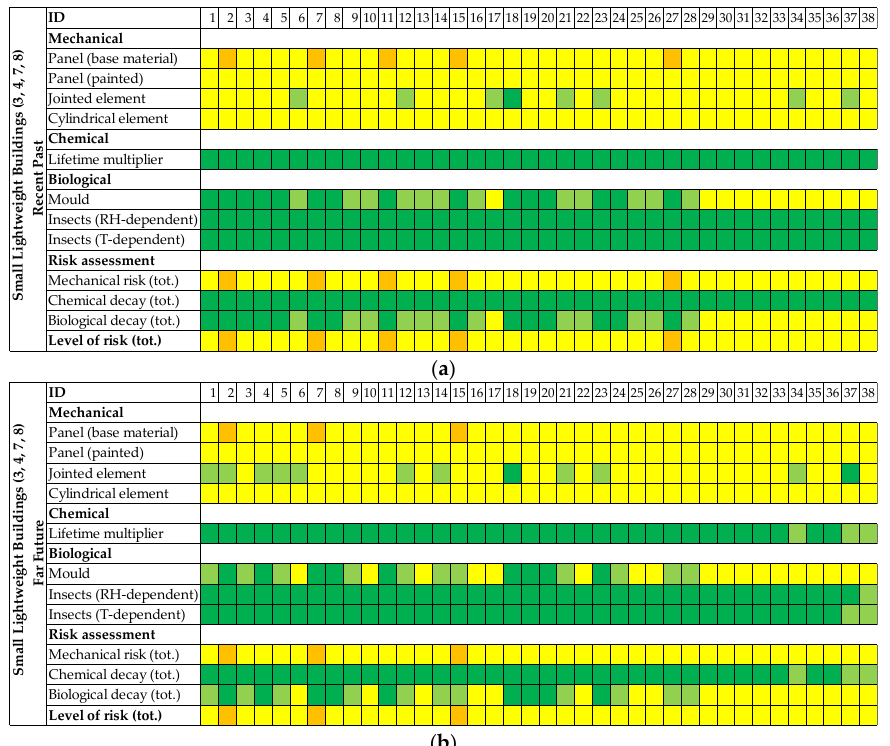
Figure 3. Risk assessment matrix of the deterioration of small lightweight buildings in: ( a ) Recent Past (1961–1990); ( b ) Far Future (2071–2100).